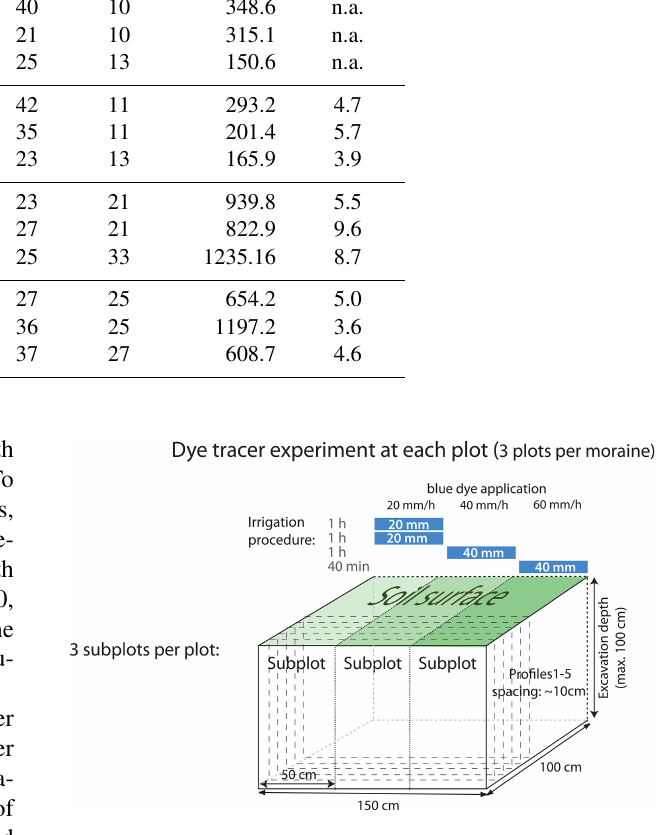
Figure 2. Illustration of the dye tracer experimental design at each